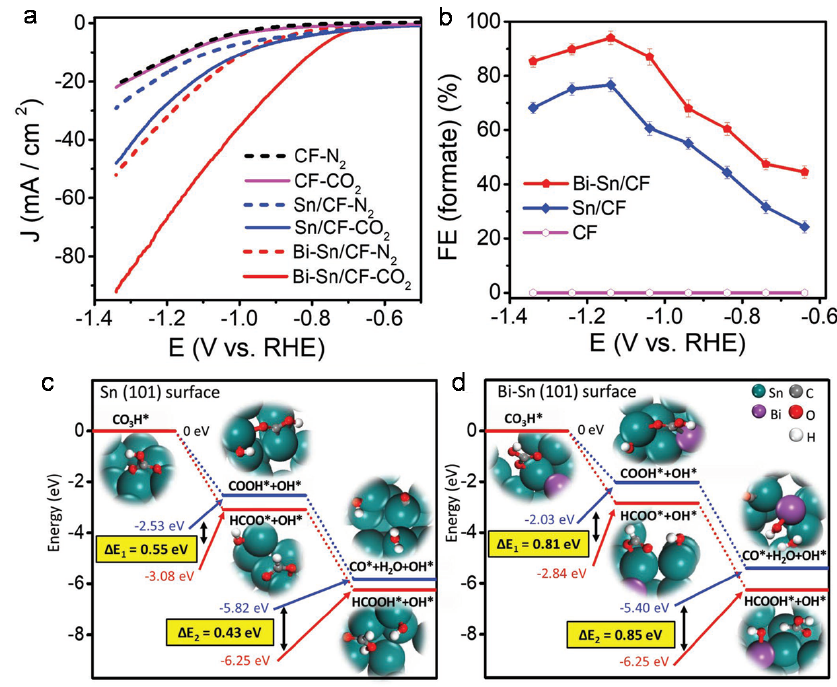
Figure 6. ( a ) CO 2 reduction reaction (CO 2 RR) activities of prepared electrodes in N 2 - (dotted line)